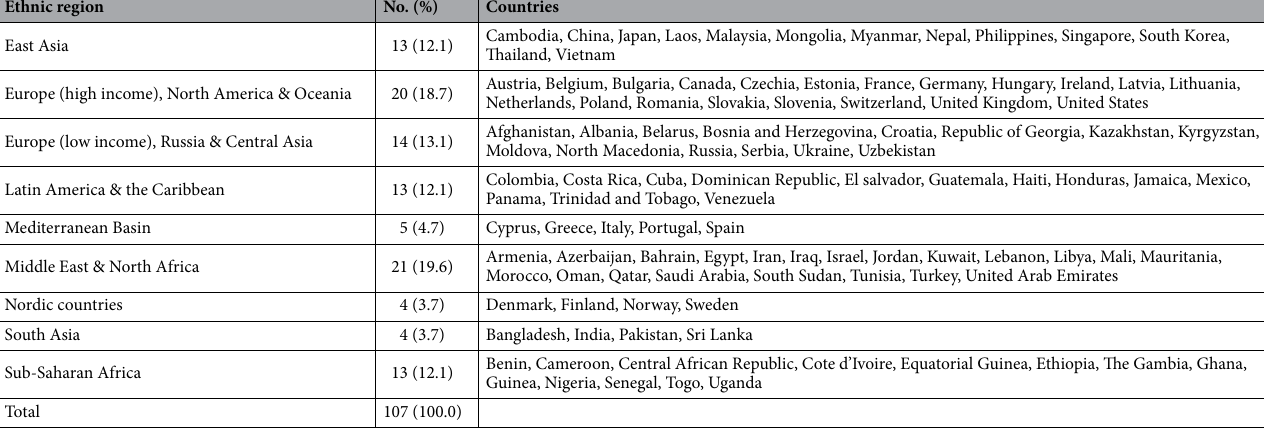
Table 1. Lists of countries in each ethnic region included in this